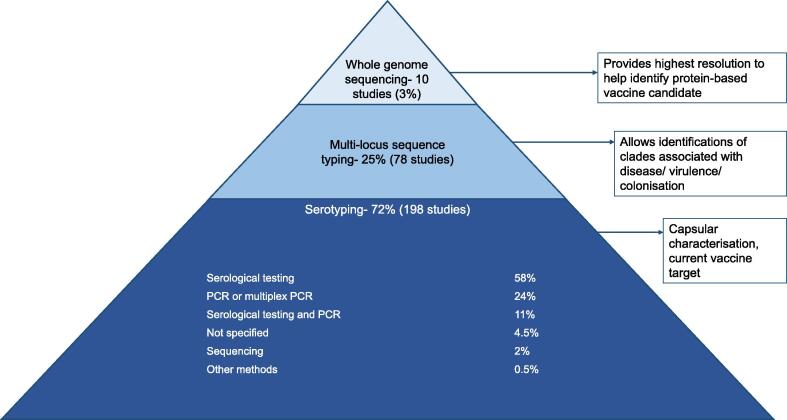
Characterisation methods used for description and investigation of GBS strains.